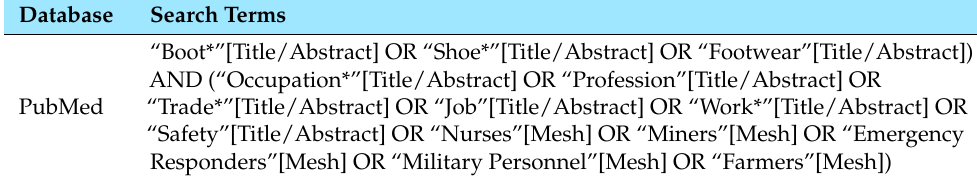
Table 1. An example of the search string used in PubMed.